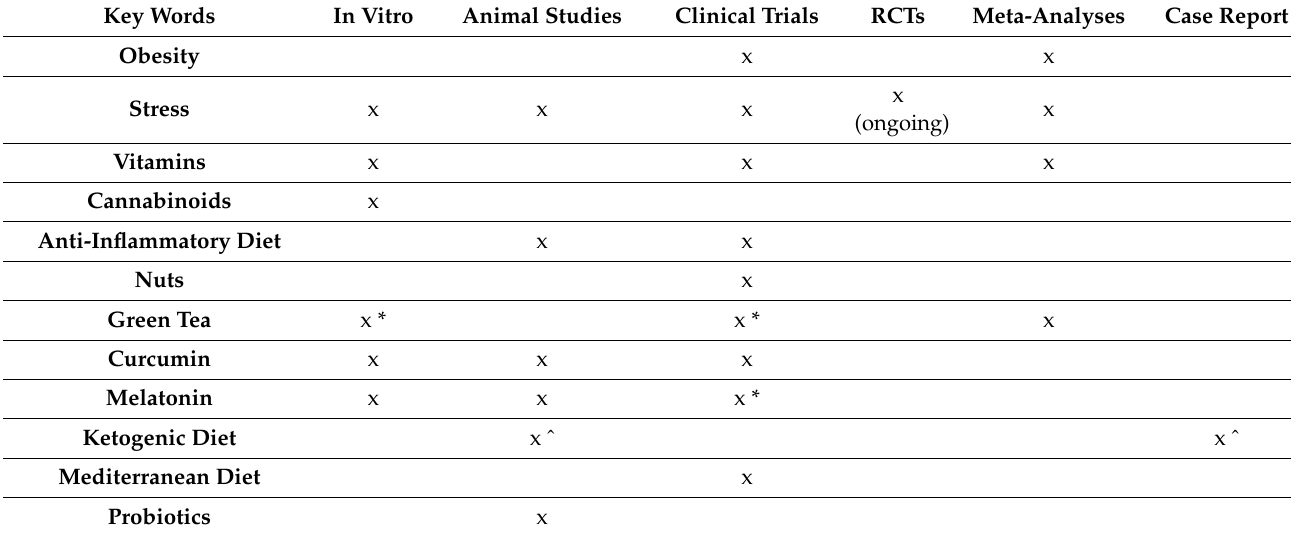
In Vitro Animal Studies Clinical Trials RCTs Meta-Analyses Case